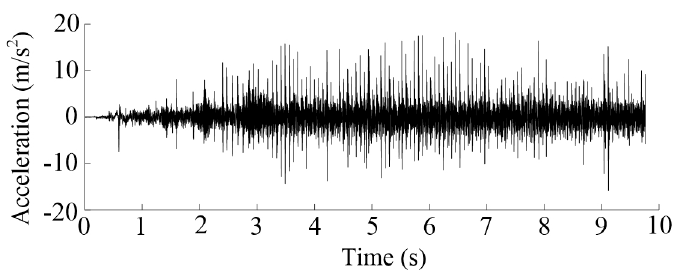
Figure 12. Time-domain diagram of the vibration acceleration signal. Note: The time-domain diagram was collected with the testing of toothed rail 1 and a 0 kg load mass.